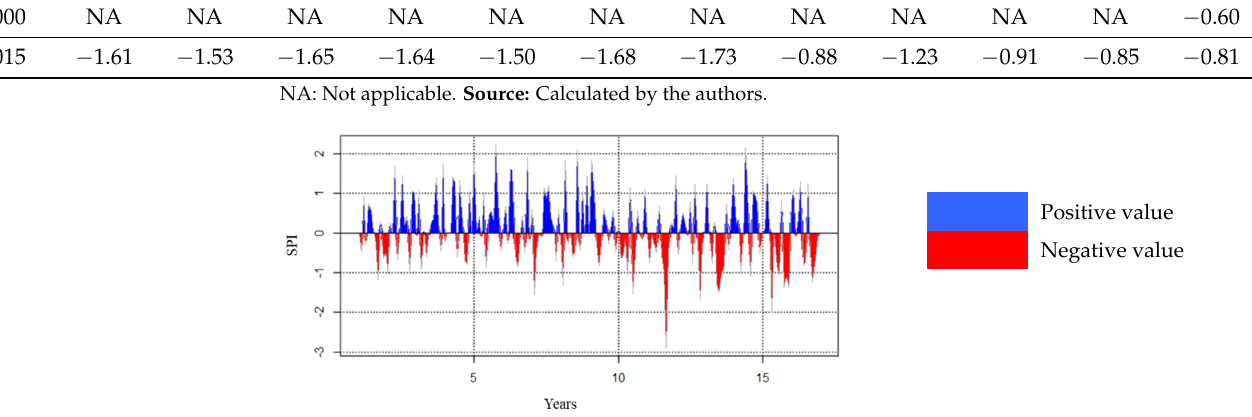
Figure 8. One-month SPI (years: 2000–2015).